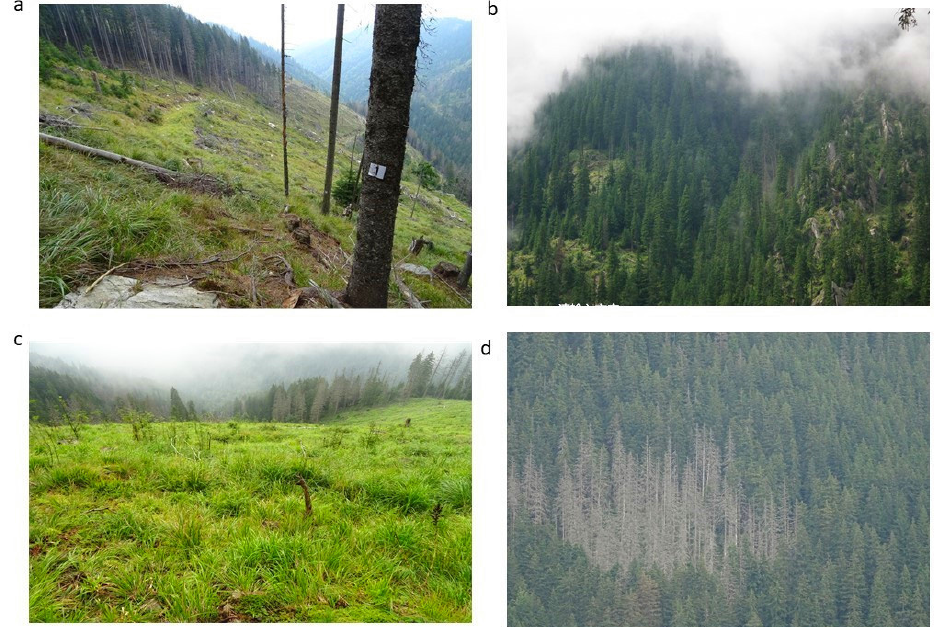
Figure 2. Current situation of the forest stands in the F ă g ă ra ș Mountains: ( a ) salvage logging of permanent study plot inside of the primary forest valley Uci ș oara (5 years after plot establishment); ( b ) primary forest stands in old-growth stage; ( c ) problems with spruce regeneration after salvage logging; ( d ) recent patches of bark beetle outbreaks.